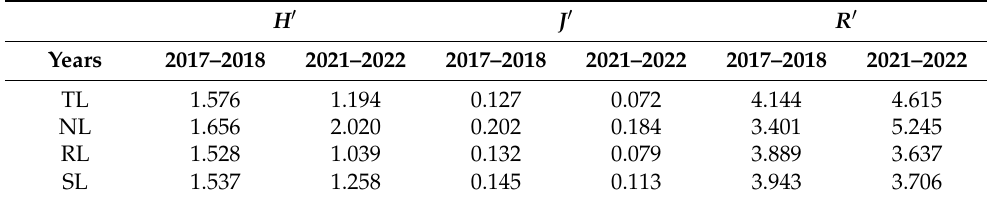
Table 6. Comparison of fish diversity indices in different areas of Gehu Lake. H (cid:48) J (cid:48) R (cid:48)